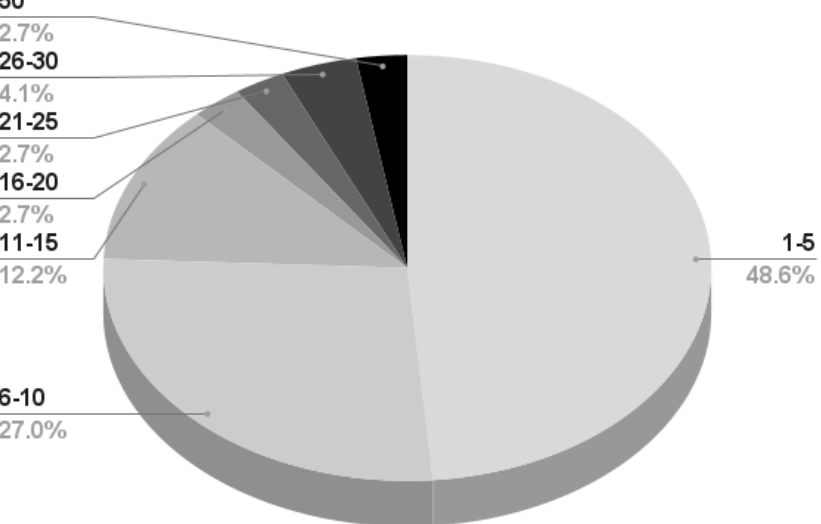
Figure 8. Number of subjects recruited by the remaining 79 works presenting information on the matter. The first number (bold black) represents the subject number range, while the second number (bold gray) is the percentage considering the total number of works. For example, 48% of the works presenting subject information recruit a maximum of five